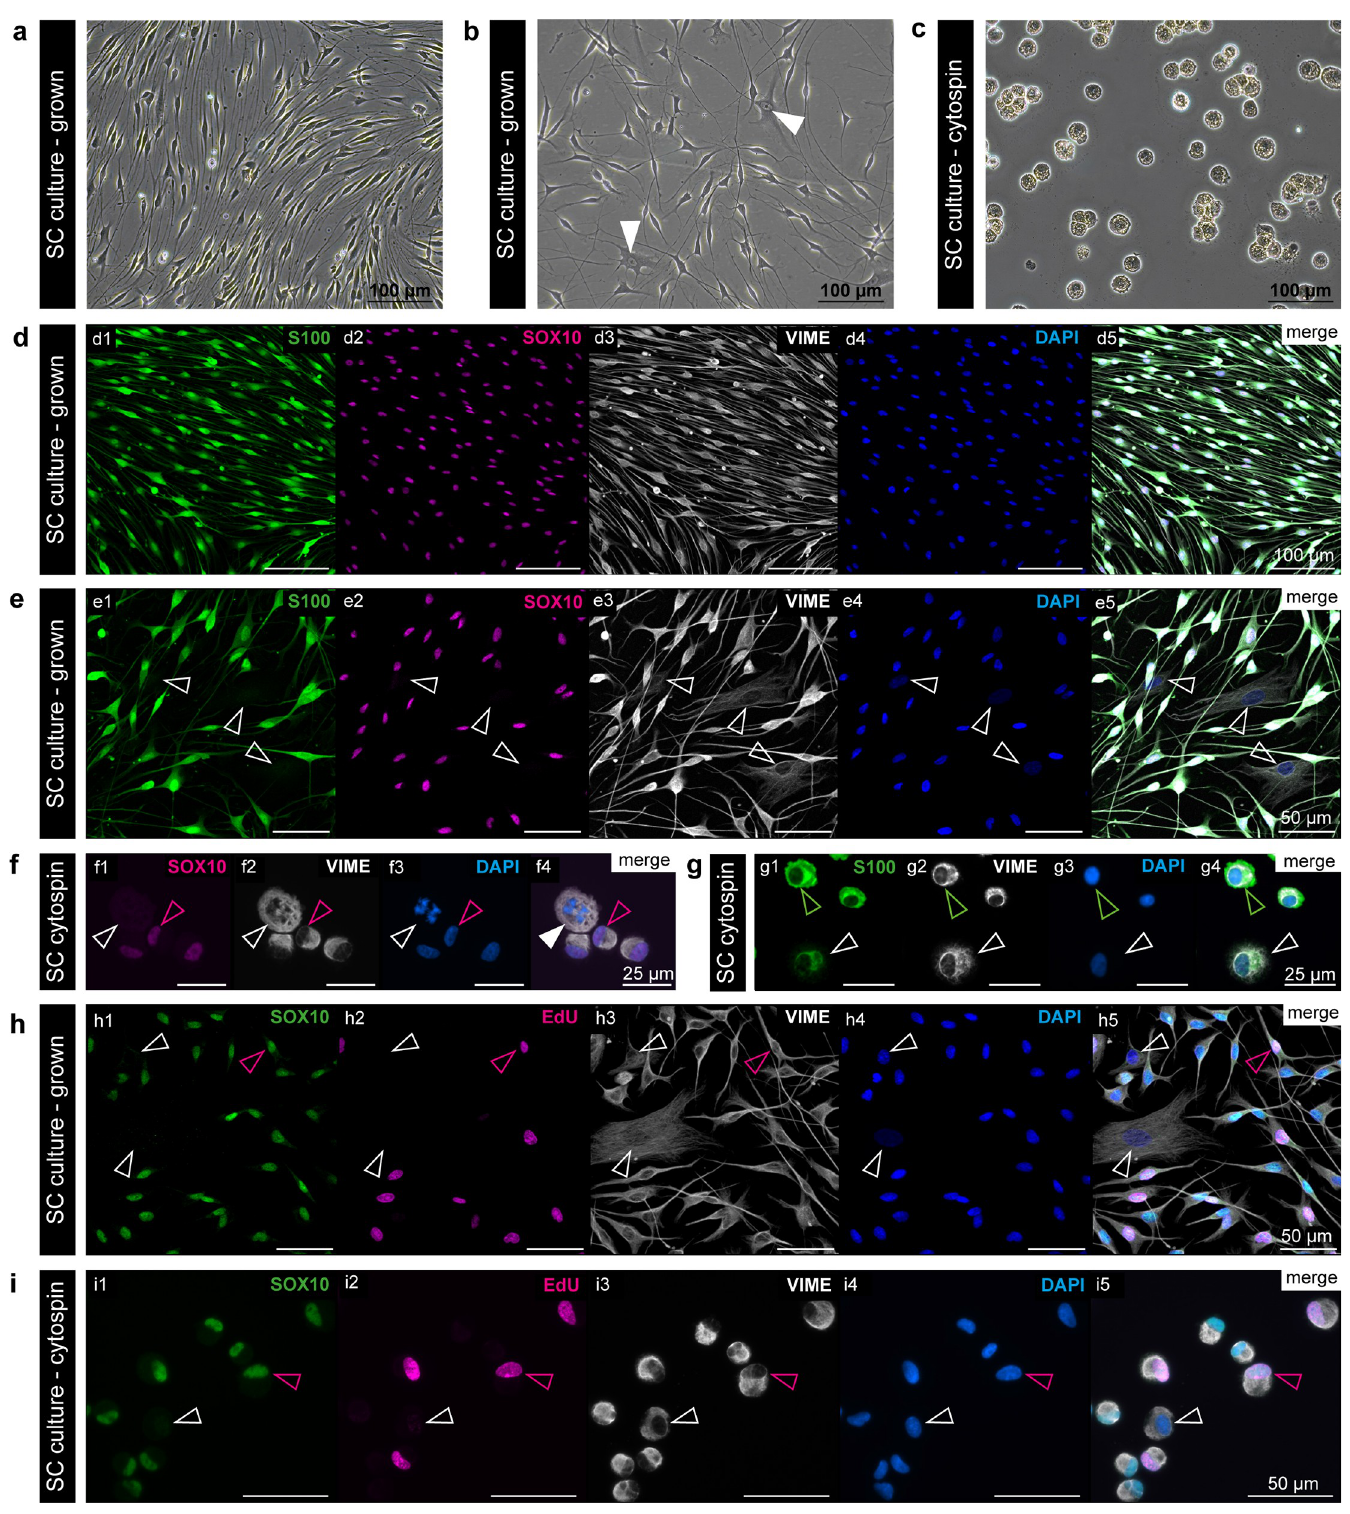
Fig 1. Evaluation of SC and proliferation markers on grown SC cultures and cytospins. (a,b) Phase contrast images of representative rat SC cultures with spindle- shaped SCs and flattened FBs (arrowheads). (c) Phase contrast image of a SC cytospin. (d,e) Immunofluorescence staining of grown SCs for (d1,e1) S100, (e2,e2) SOX10, (d3,e3) VIME, (d4,e4) DAPI and (d5, e5) merged channels; arrowheads mark S100 - /SOX10 - /VIME + FBs. (f) Representative cytospin image of SCs stained for (f1)